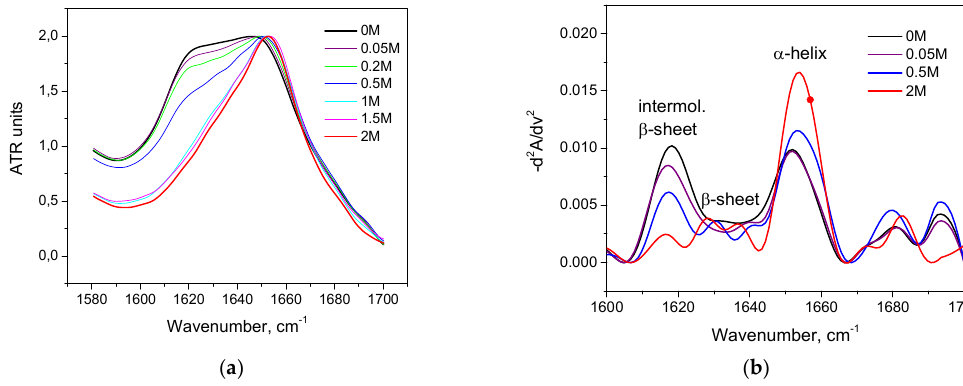
Figure 17. Changes in the character of the Amide I band ( a ) and changes in the second derivative of the Amide I band ( b ) of HSA in 10% wt. aqueous solution at 80 °C with various concentrations of (NH 4 ) 2 SO 4 . Only the most representative curves are shown for the sake of clearness.